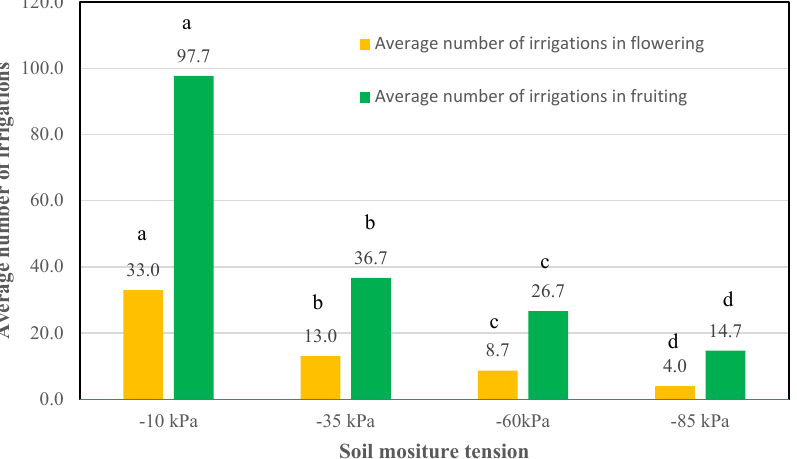
Figure 3. Average number of irrigations during the phenological stages of flowering and fruit growth, in treatments with the same soil moisture tension at both stages (T1, T3, T9, and T16). Different letters in the bars corresponding to each phenological stage indicate statistically significant differences (Tukey, p ≤ 0.05).